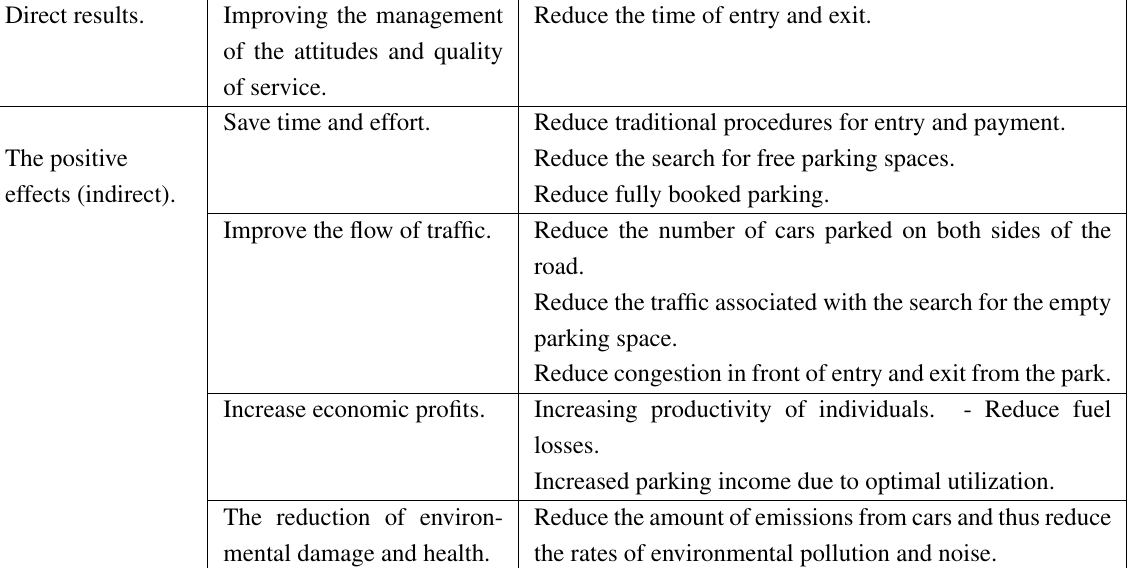
Table 3. Results of Smart payment systems and the positive effects (Adeeb, 2016). Direct